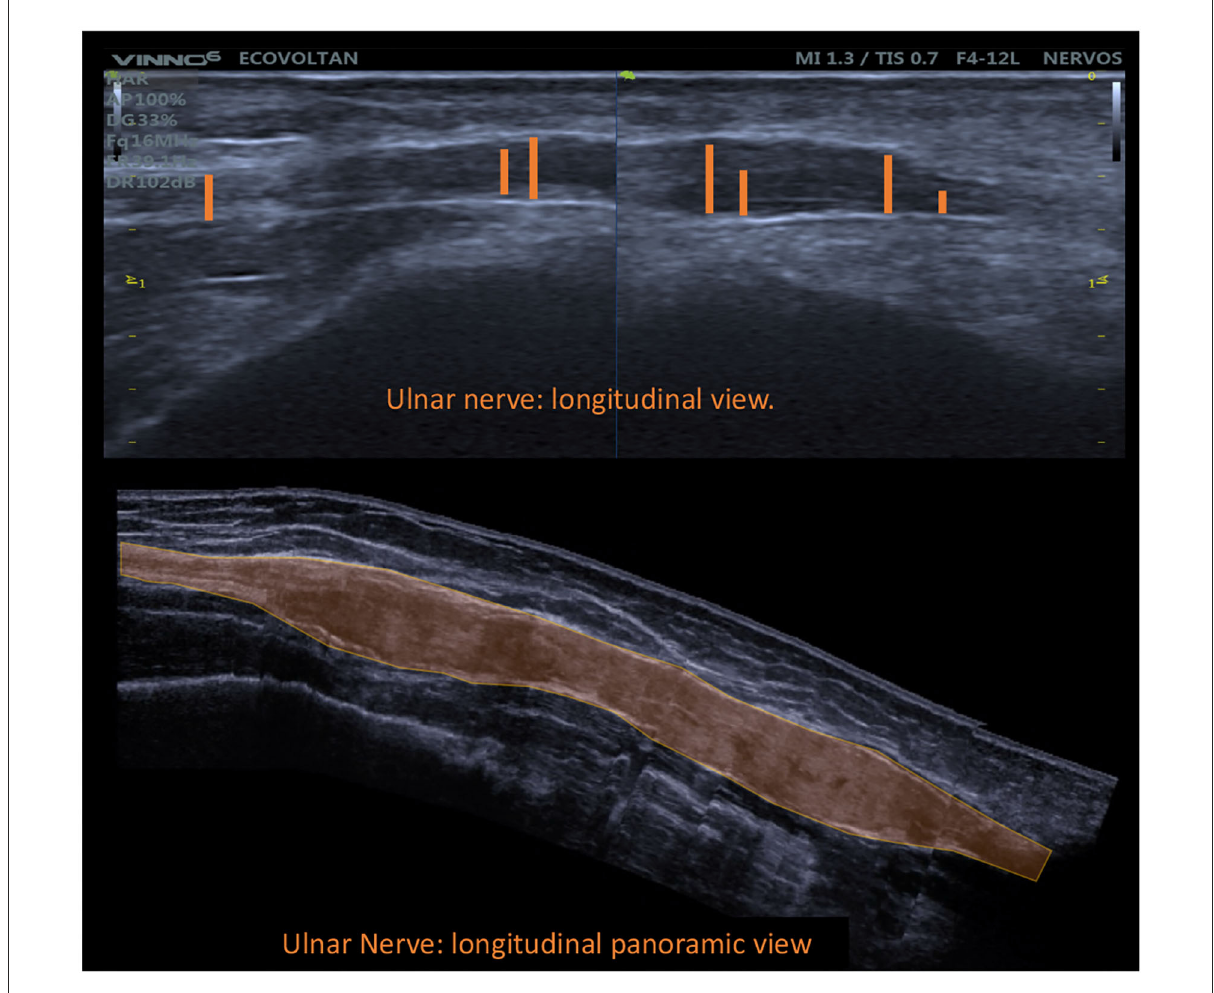
FIGURE7 Longitudinal view of the common fibular nerve with fusiform enlargement demonstrating focality ( 1